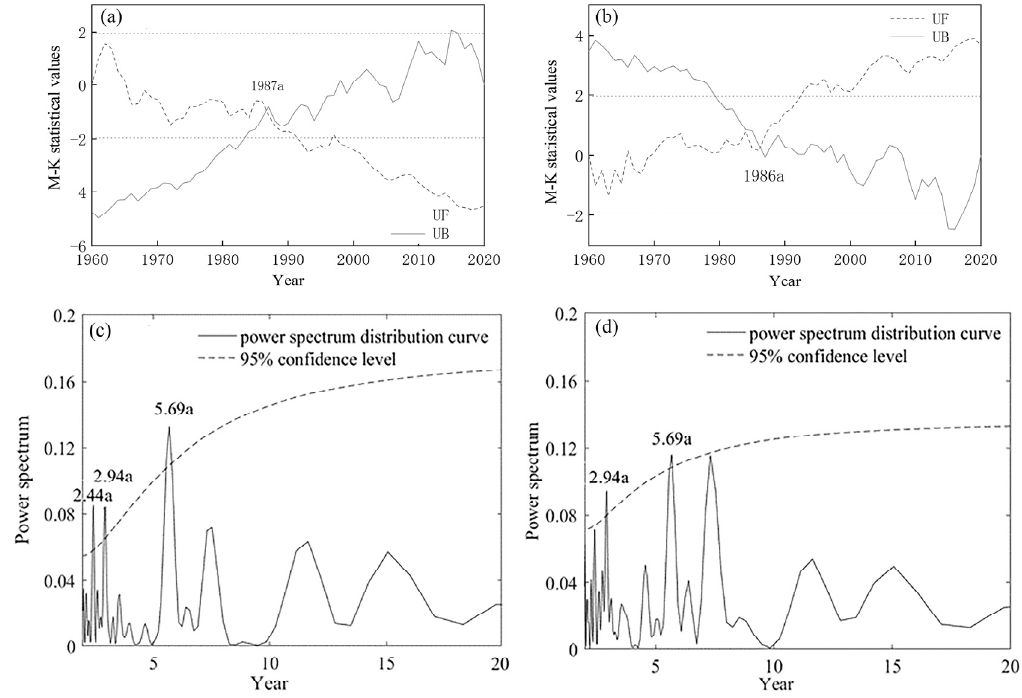
Figure 5. Frequency mutation curves and power spectrum of extreme drought ( a , c ) and wet ( b , d ) events in Xinjiang from 1960 to 2020.